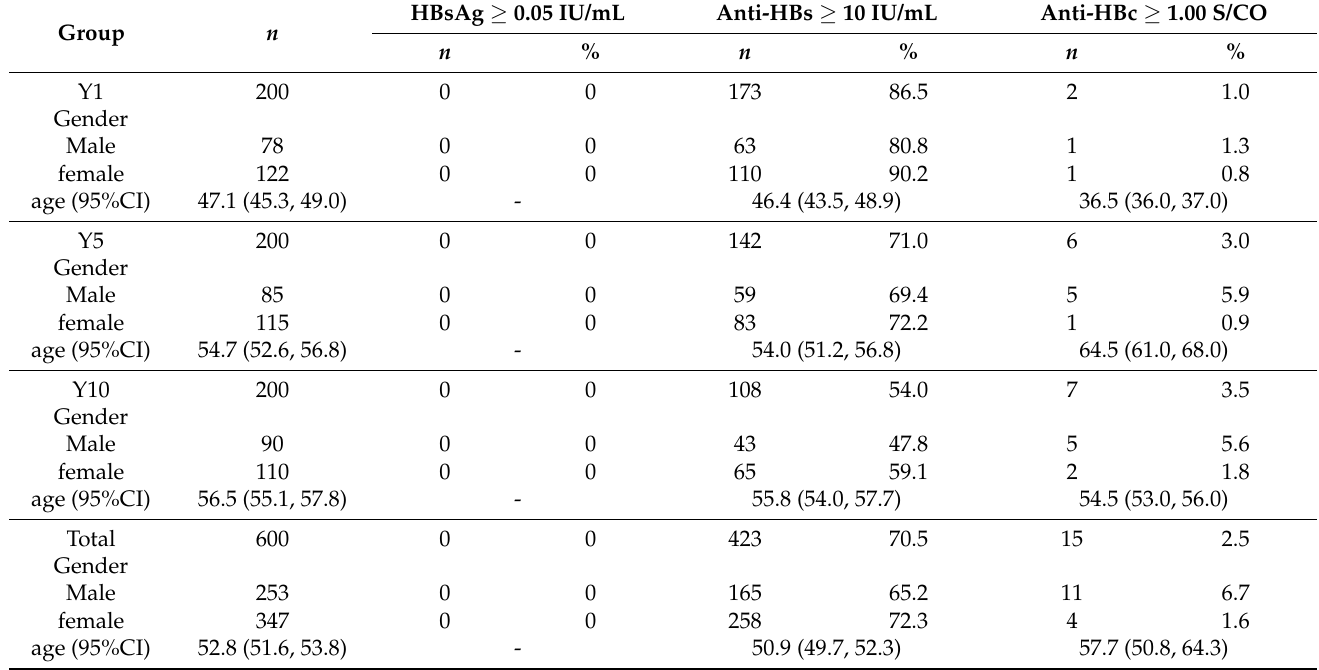
Table 1. Demography and HBV serological test results for all study subjects.